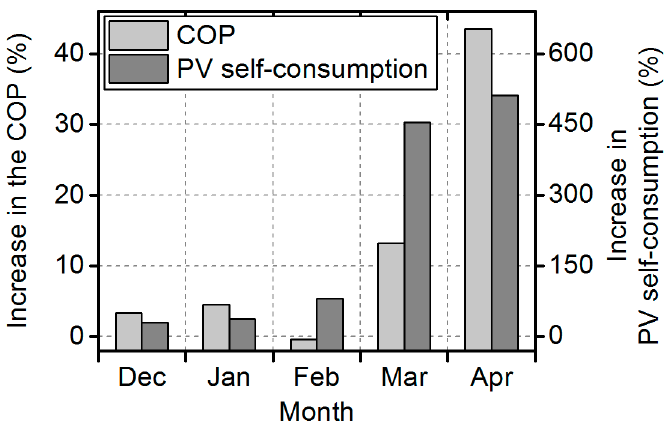
Figure 6. ( a ) Monthly mean ambient temperature and daily heat demand in the reference test rig; ( b ) mean solar irradiation and mean daily temperature spread during the measurement.